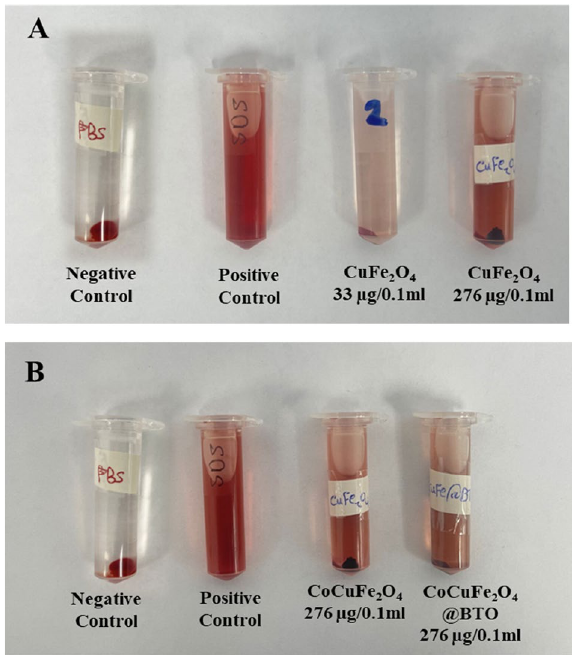
2 O 4 ) with respect to positive and negative control. ( B ) The effect of the presence BTO biocompatible layer in CoCuFe 2 O 4 at the highest concentration 276 µg/0.1